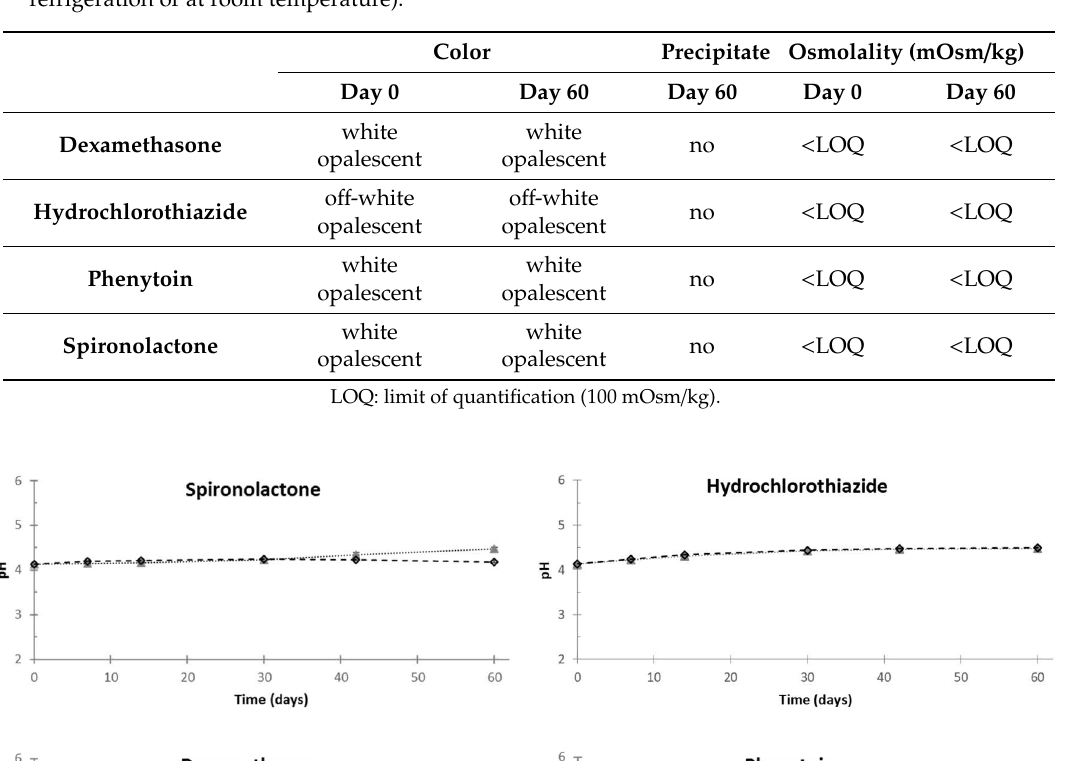
Table 5. Physical parameters assessed during the stability study of dexamethasone, hydrochlorothiazide, phenytoin, and spironolactone oral suspensions regardless of the type of storage conditions used (under refrigeration or at room temperature).